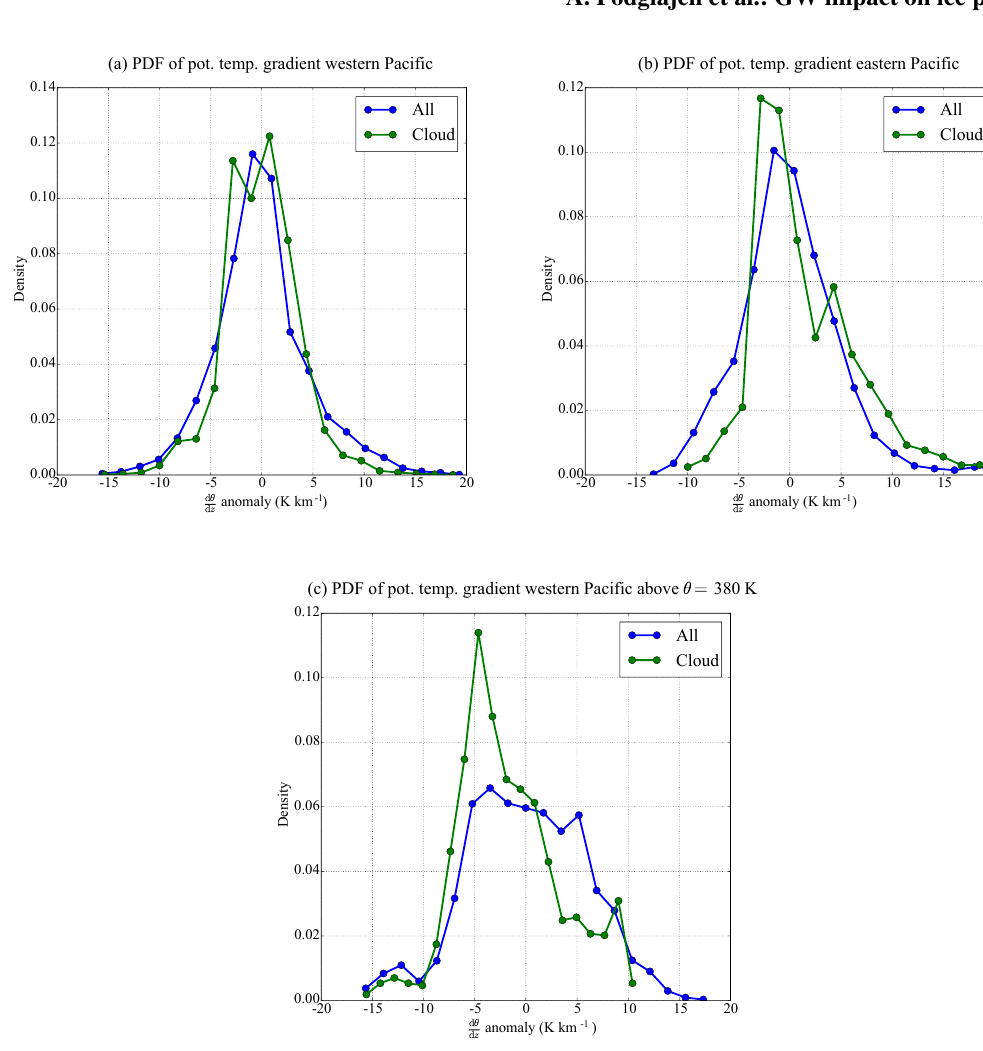
(cid:16) ∂θ (cid:17) Figure D2. Anomalies of stability distributions out of and within clouds from ATTREX observations in the (a) western Pacific, 2014, ∂z and (b) eastern Pacific, 2013. Panel (c) also corresponds to the western Pacific but only data above the potential temperature level